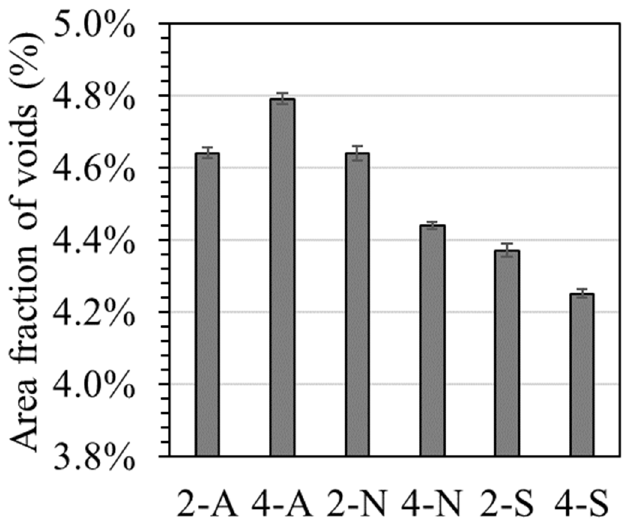
Figure 6. Area fraction of voids on anodic oxide films with different pretreatment and sealing meth- ods.